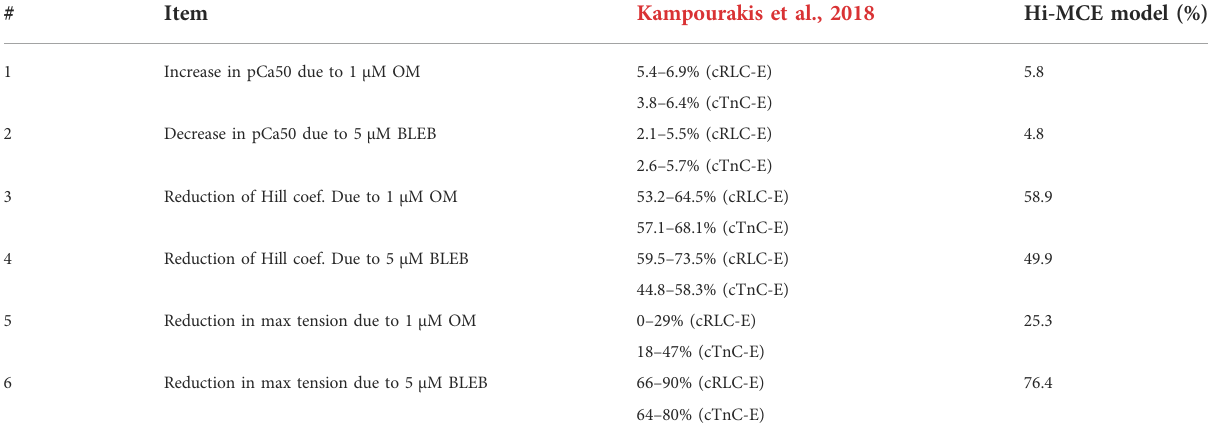
TABLE7Experimentaldata(Kampourakisetal.,2018)andhiMCEresultsduetotheeffectof1 µMOMand5 µMBLEB.pCa 50 representsthe-logofthe Ca 2+ concentration associated with 50% of maximum tension. cTnC-E: data from cardiac troponin C (cTnC) E-helix obtained by a